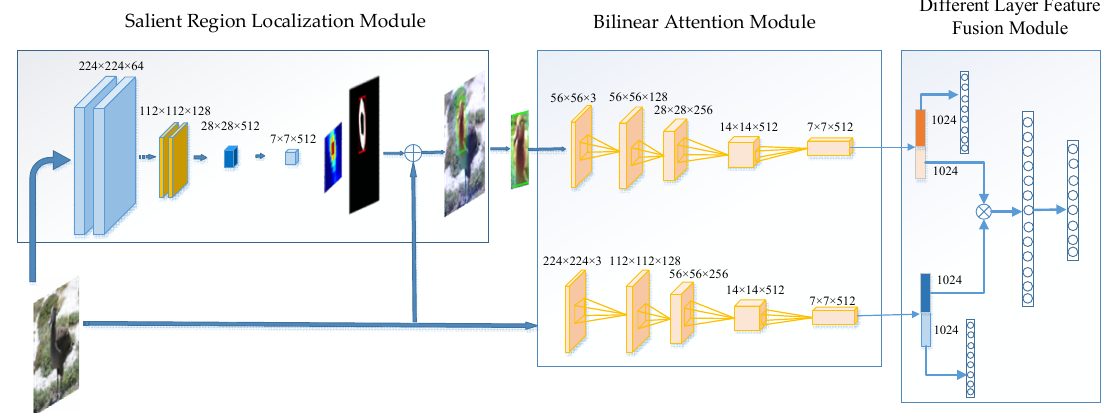
Figure 2. Overview of our neural network’s structure. The whole neural network is a two-level attention model. The saliency module is used for locating salient regions of the target images, then the bilinear attention module is used as our feature extractor. Finally, the derived features are used to calculate the outer product to achieve the final fused feature.